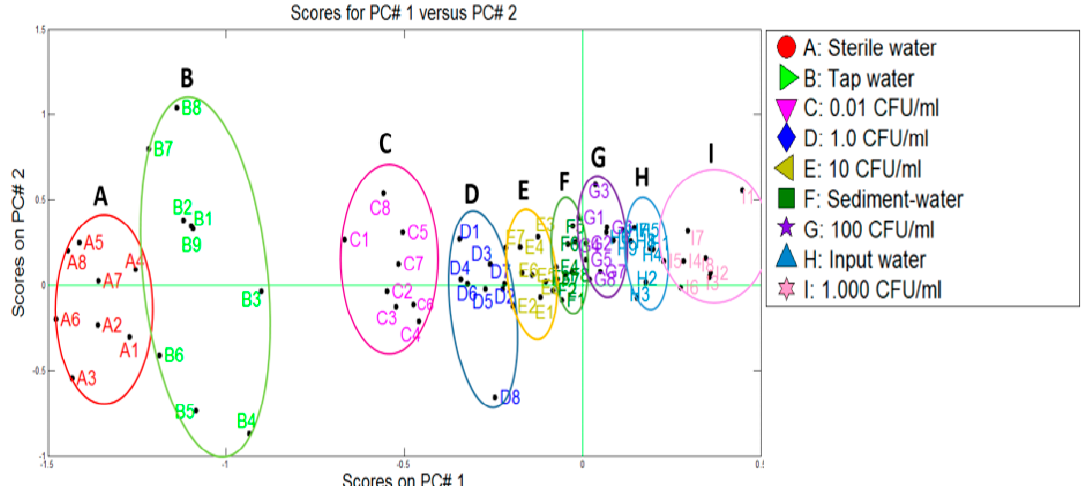
Figure 7. PCA plot of the set of measurements of training samples and samples taken of Empopamplona plant.